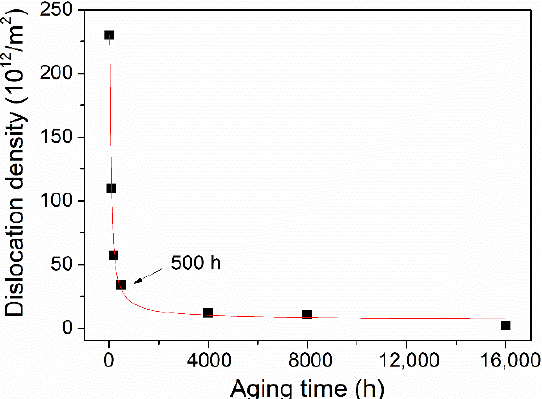
Figure 5. The evolution of dislocation density in the present P91 steels with respect to their different aging durations. aging durations.